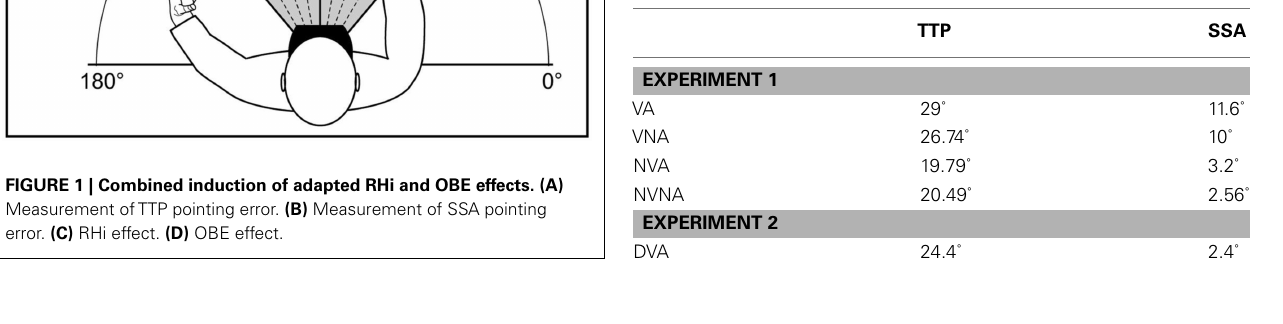
Table 1 | Mean experimental angles α (degree) for tip-of-the-piston (TTP) pointing error, and β (degree) for subjective-straight-ahead (SSA) pointing